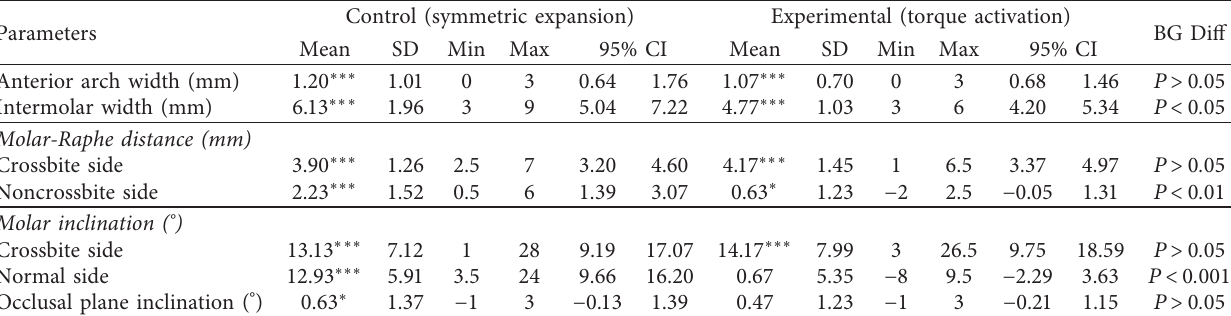
Table 2: Post-treatment changes in each group (i.e., changes occurred during treatment and measured after it), and the comparison of change extents in both